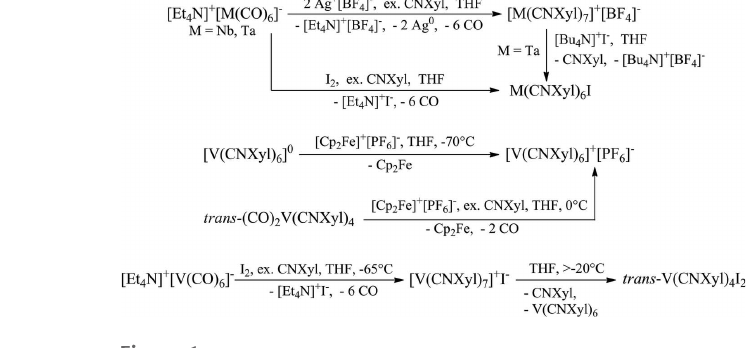
Figure 1 Scheme showing preparation and transformations of some isocyanide complexes of group 5